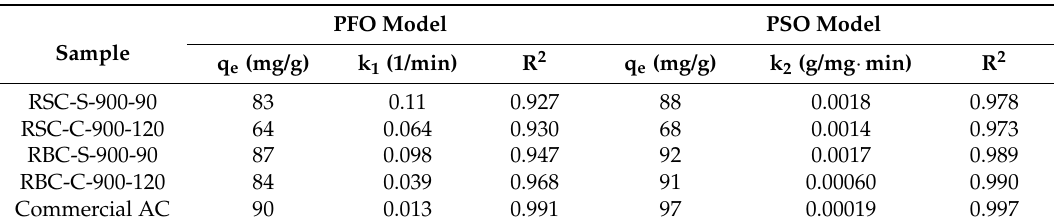
Table 5. Parameters of the pseudo-first-order (PFO) and the pseudo-second-order (PSO) model of selected ACs produced from RSC (after HCl washing) and RBC, compared to those of commercial